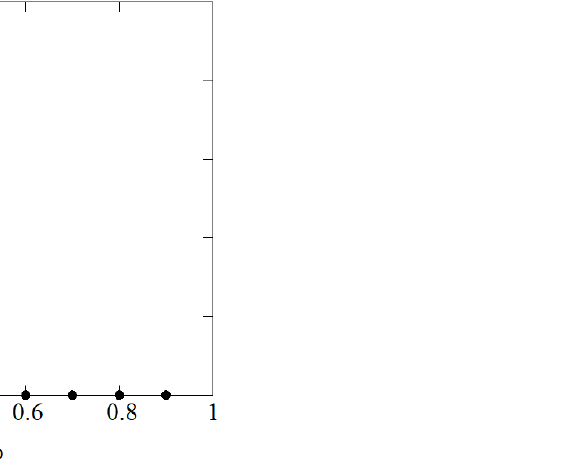
Figure 9. Most appropriate percentage of power contribution from ammonia against the weight assigned to N 2 O emissions.